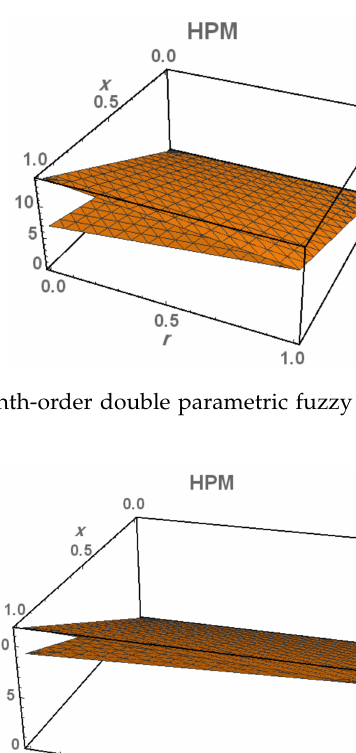
Figure 9. Solution of the tenth-order double parametric fuzzy HPM at t = π , b = 0,1 for all x ∈ [ 0,1 ] and r ∈ [ 0,1 ] .